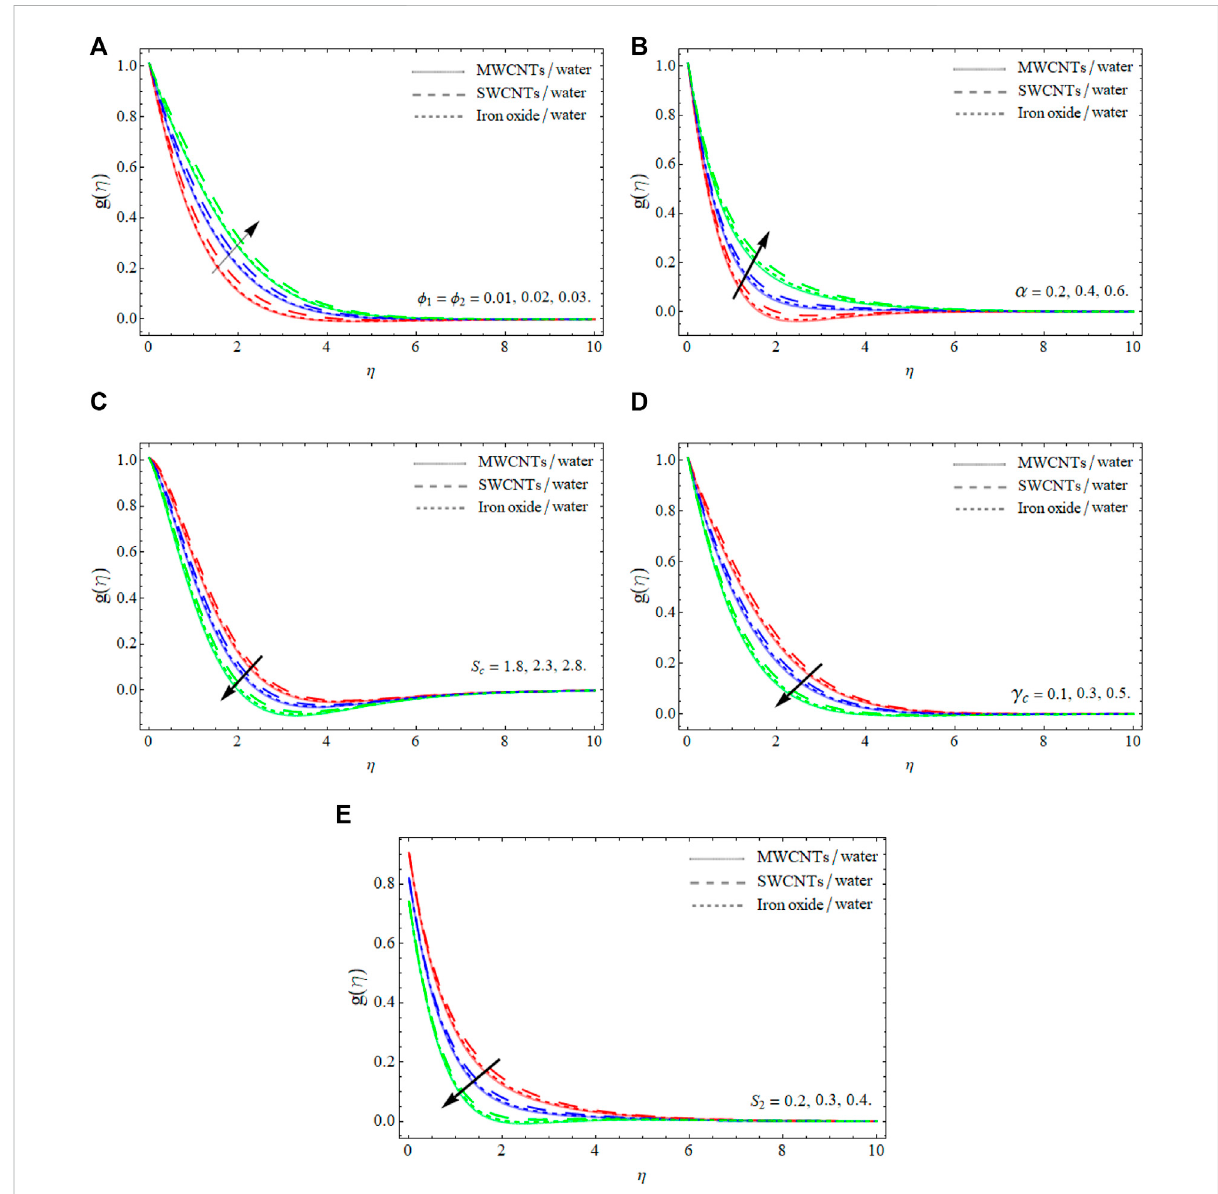
Figure 3E, the effect of the radiation term Rd on the fl uid ’ s temperature fi eld is investigated. As the radiation number upsurges, the fl uid temperature rises. When the radiation term is increased, the fl uid absorbs more heat, causing the fl uid temperature to rise. The impact of thermal strati fi cation parameter S 1 is shown in Figure 3F. It is to be noted that the energy pro fi le decreases for larger values of S 1